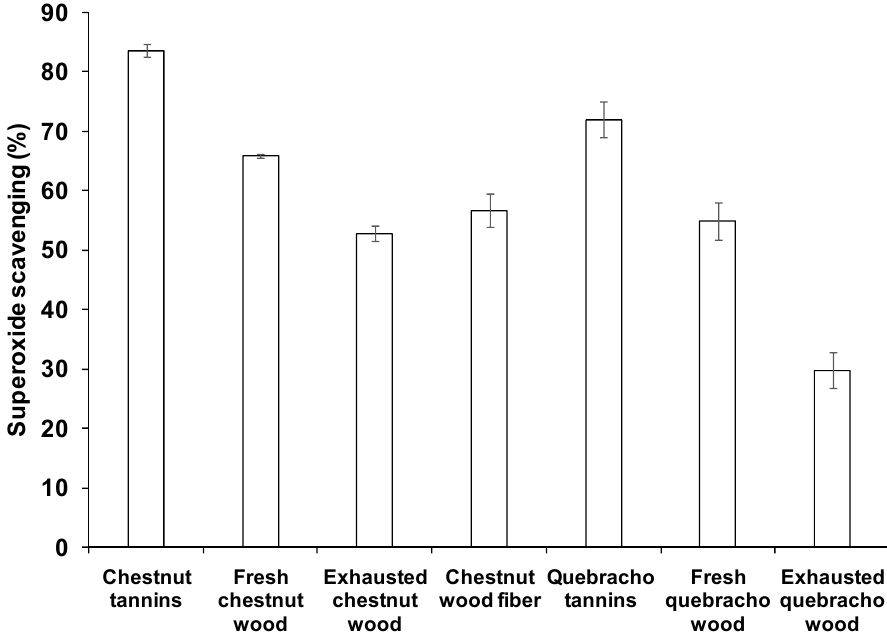
Figure 6. Superoxide scavenging activity of tannins and wood samples. Reported are the mean ± SD values of at least three experiments. Table 3. Activity of tannins and wood samples in the oxygen radical antioxidant capacity (ORAC) assay.